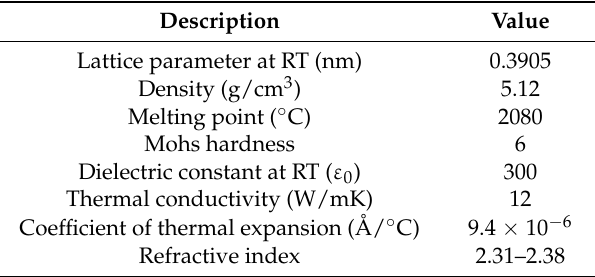
Figure 1. Schematics of typical perovskite structure showing strontium titanate (STO) (100) 1 × 1 × 2 cell and the [TiO 6 ] basic octahedral units. The axis containing Ti–O–Ti between both unit cells is clearly observed. Table 1. Summary of the main physical properties of STO.